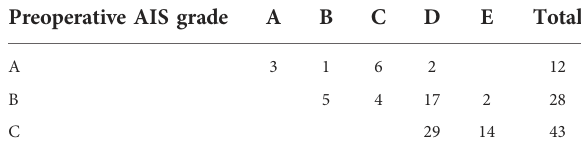
TABLE 3 Changes in American spinal injury association impairment scale (AIS) grade from pre-operative to fi nal follow-up.